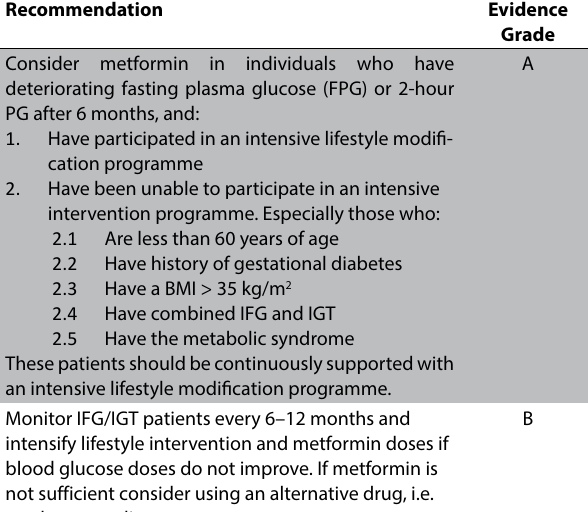
Table 11: Evidence Graded approach for prescribing pharmacotherapy in patients with IFG/IGT 45 Recommendation